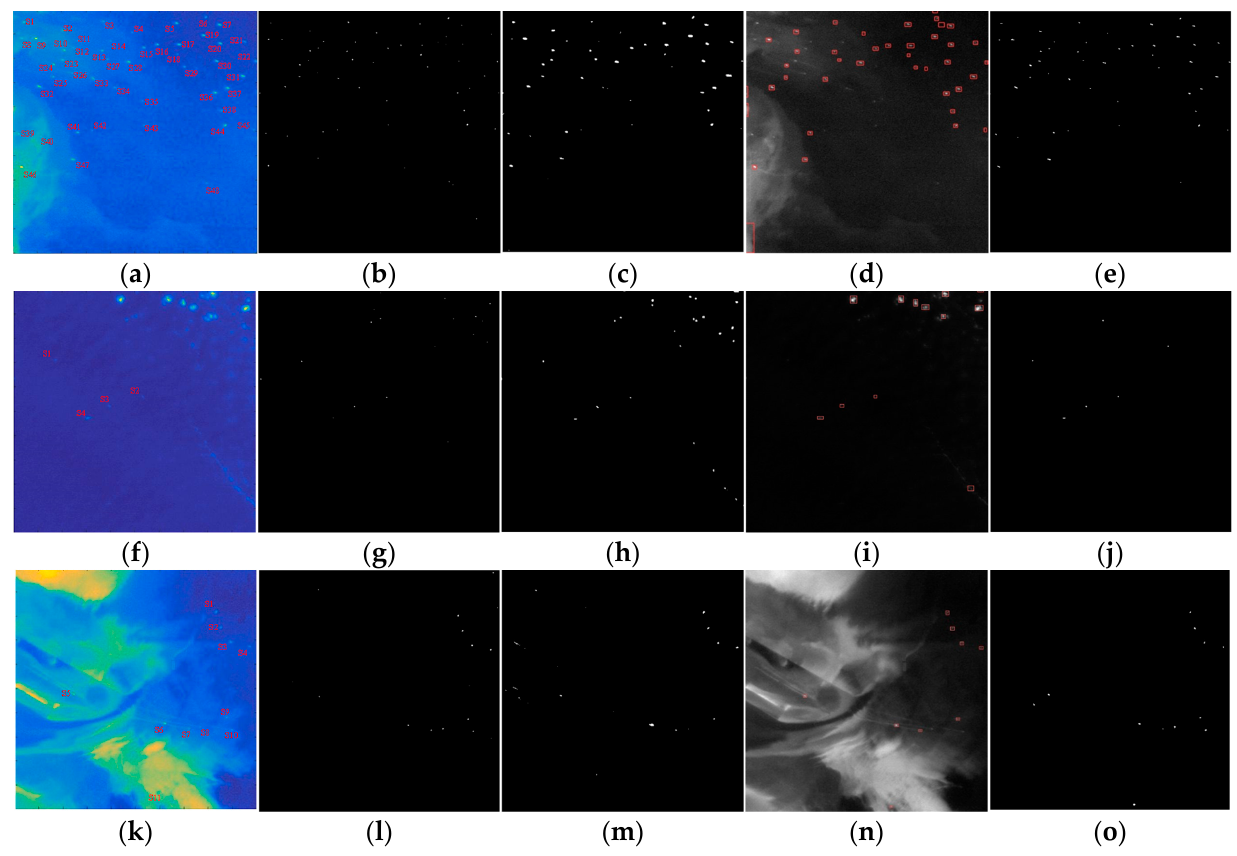
Figure 14. Comparison of visual effects on ship detection: ( a , f , k ) are locally enlarged GF-4 image chips; ( b , g , l ) are corresponding results of Liu et al. [6]; ( c , h , m ) are results of Yao et al. [5]; ( d , i , n ) are results of Wang et al. [7]; ( e , j , o ) are results of ours. Table 1. Metrics comparison of ship detection and tracking.